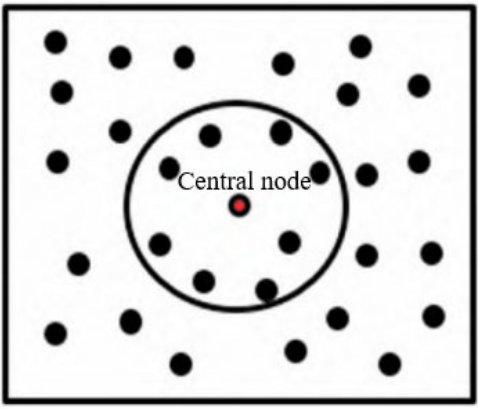
Figure 1. An irregular cloud of points and the selection of star via distance criterion.